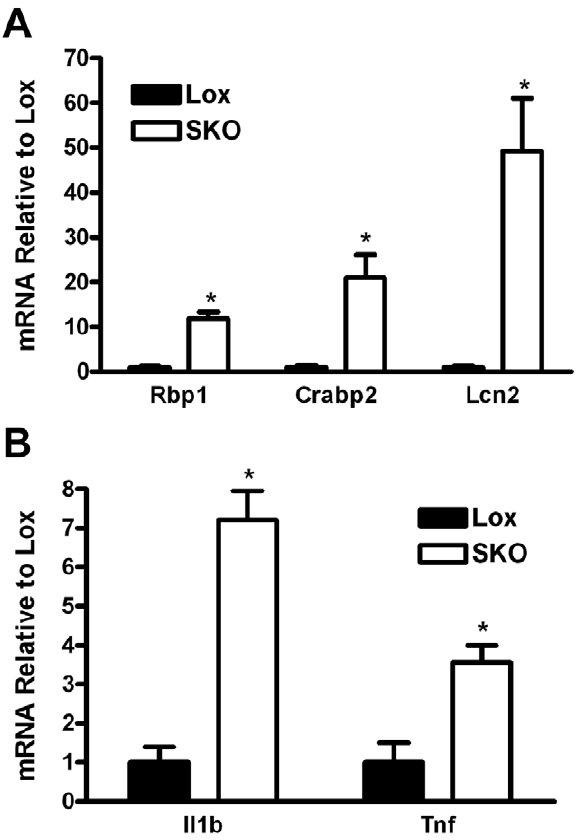
Figure 4. Elevated retinoic acid metabolism and inflammatory genes in 23 day old SKO skin. RNA was isolated from skin of 23 day old postnatal Lox and SKO mice and subjected to real-time PCR analysis and normalized to levels of 18S as described in Methods . The expression of A) retinoic-acid regulated genes ( Lcn2 , Rbp1 , Crabp2 ) and B) inflammation genes ( Il1b , Tnf ) were significantly elevated in SKO mice at 23 days. All values are expressed as fold difference relative to Lox mice. Data represent mean 6 SEM for n=4–6 per group. *= p ,